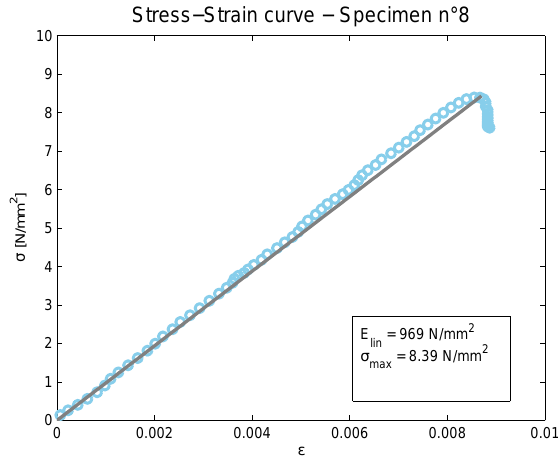
Figure 11: Stress-strain curve for specimen 7.